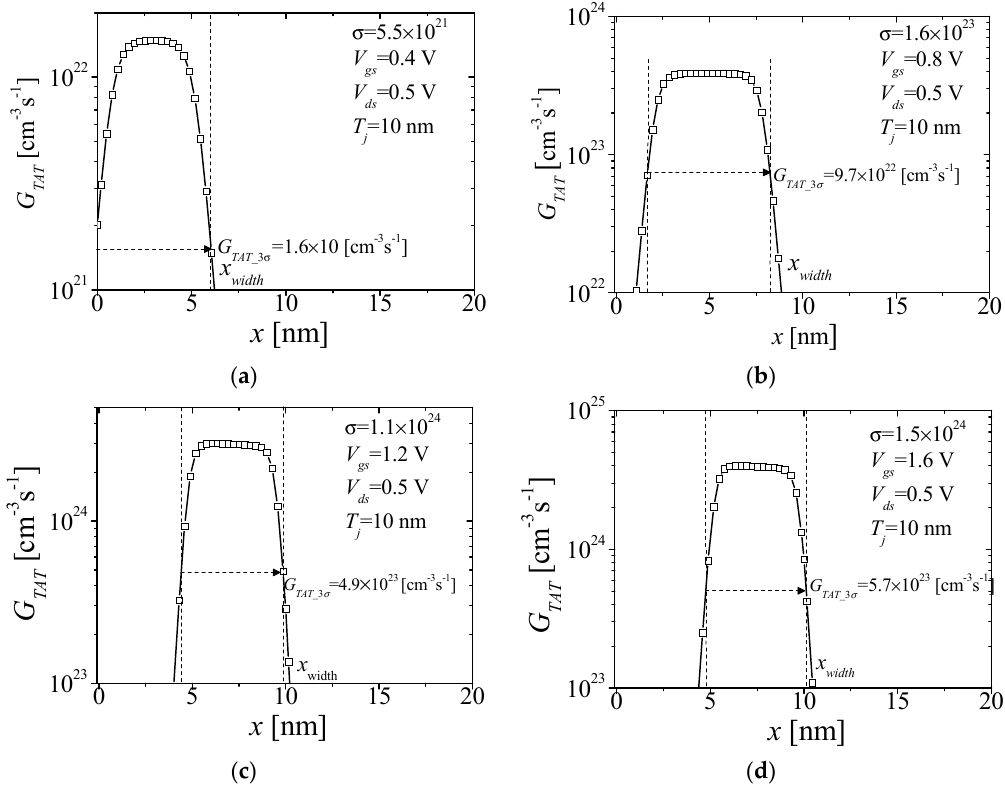
Figure 4. ( a – d ) Illustration of the method used to estimate the width of the Gaussian distribution. G TAT is shown, and x width is pointed out by arrows, for V gs = 0.4, 0.8, 1.2, and 1.6 V, respectively.